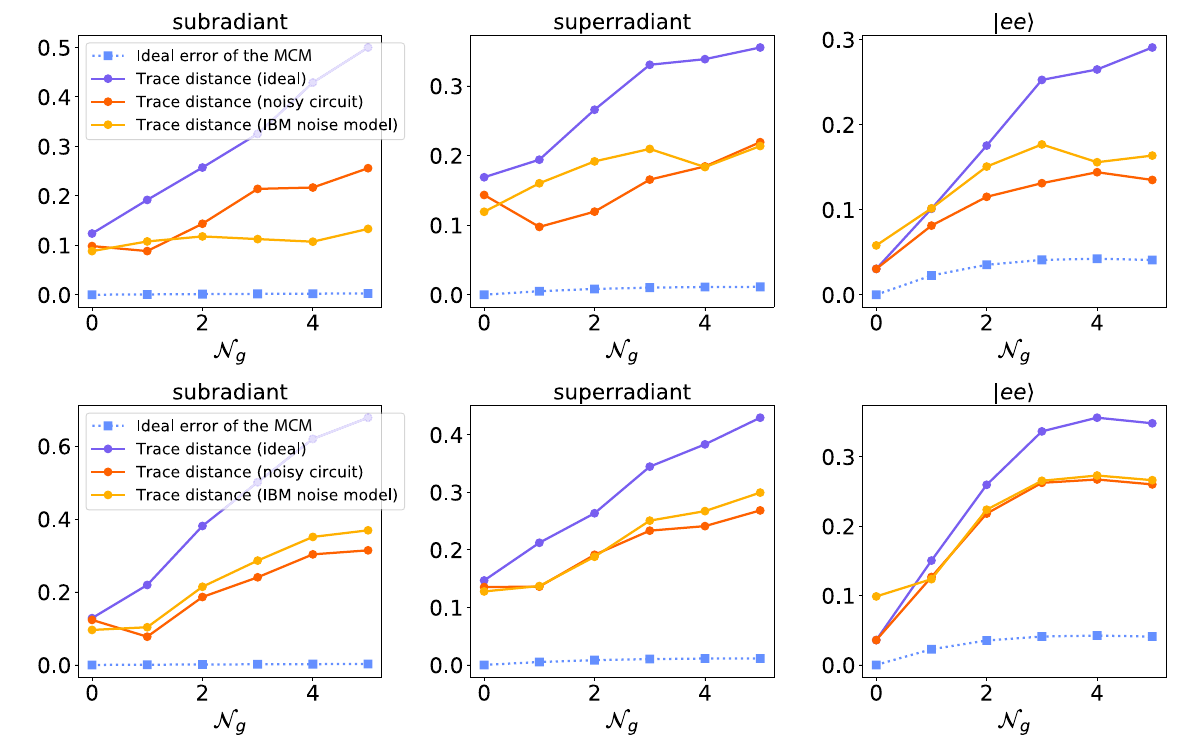
FIG. 13. The trace distance between the experimental state and the ideal state of the algorithm (continuous violet line), the simulated state through the noisy circuit (continuous orange line), and the simulated state through the IBM noise model (continuous yellow line), as a function of the number of gates in the algorithm N g and for the first set of results in Fig. 2 (first row) and the second set of results in Fig. 8 (second row). The markers indicate the steps of the collision model. The dotted light blue line depicts the trace distance ( n ) between the state of the MCM at each time step of the dynamics and the ideal physical state driven by the master equation, (cid:9) ideal according to Eq.